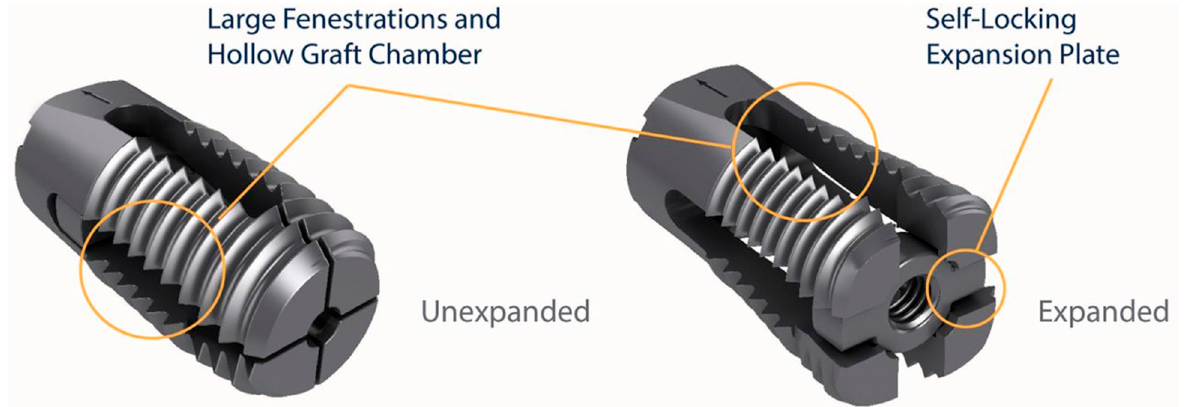
Figure 1. VariLift ® -LX stand-alone lumbar interbody fusion device (Wenzel Spine, Austin, TX, USA) shown in unexpanded and expanded configurations.